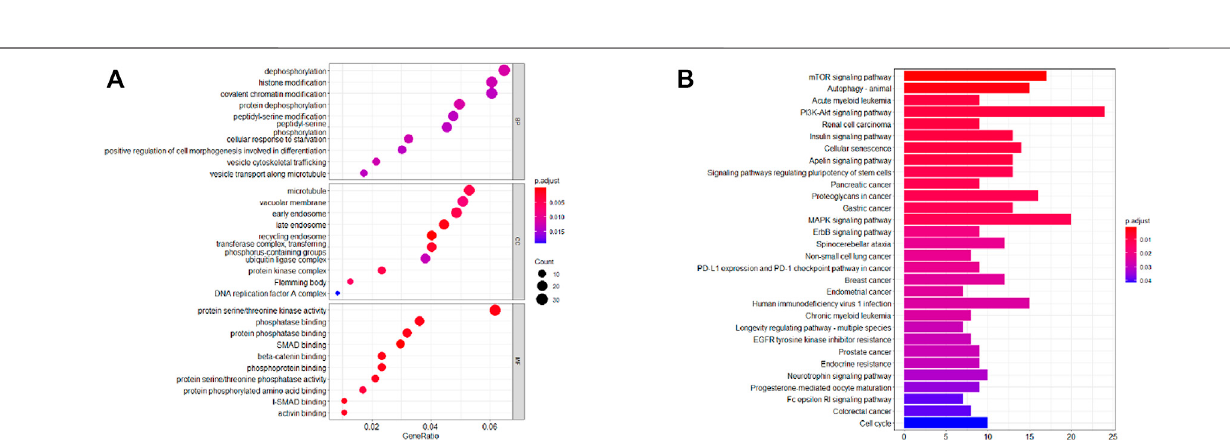
Frontiers in Genetics |